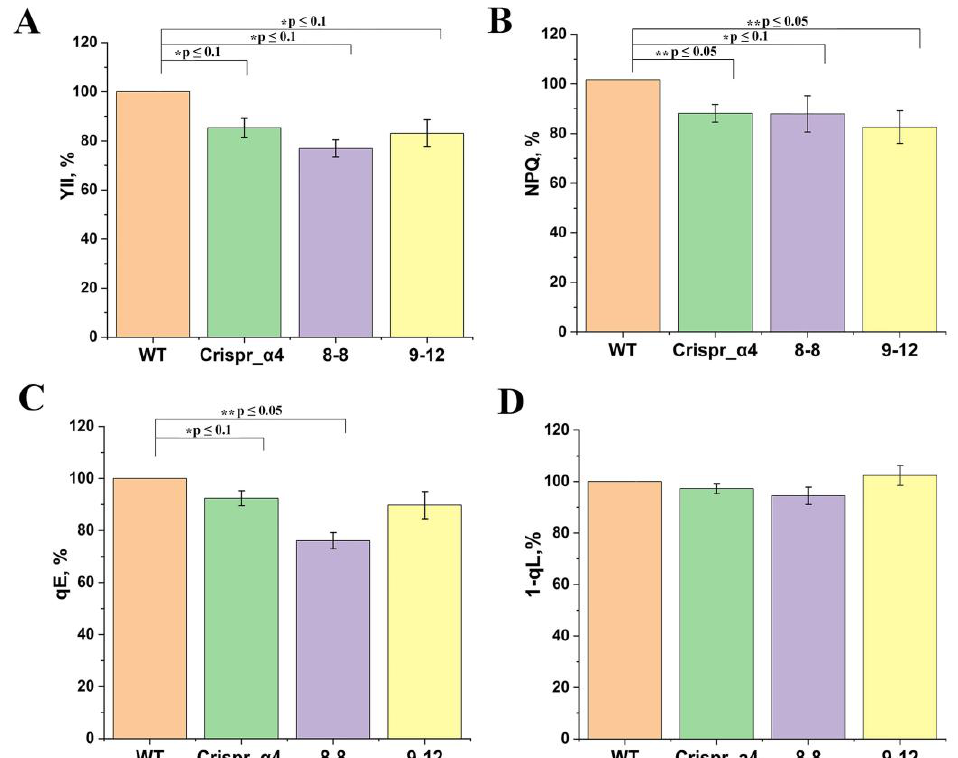
Figure 4. The effect of α CA4 knockout on the quantum yield of PSII, Y II ( A ), total non-photochemical quenching of chlorophyll a fluorescence, NPQ ( B ), the coefficient of energy dependent component of nPQ, qE ( C ), and the coefficient 1-qL ( D ) in intact leaves of the WT Arabidopsis plants and α CA4-KO: Crispr_α4, 8 -8 and 9-12. The calculations of the parameters are presented in Materials and Methods. The values were measured in 7 min after illumination with continuous light at a photon flux density of 530 μmol quanta/(m 2 s) PAR and at ambient air CO 2 concentration. The 100% values were the data for the WT plants: Y II of 0.13, NPQ of 1.59, qE of 0.29 and 1-qL of 0.66. Significant differences are denoted as * p ≤ 0.1, ** p ≤ 0.05.